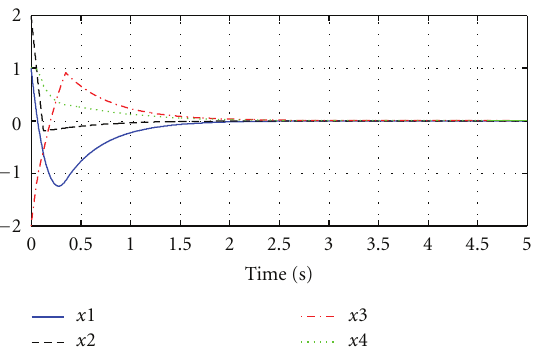
Figure 4: System states with applying the saturation function.